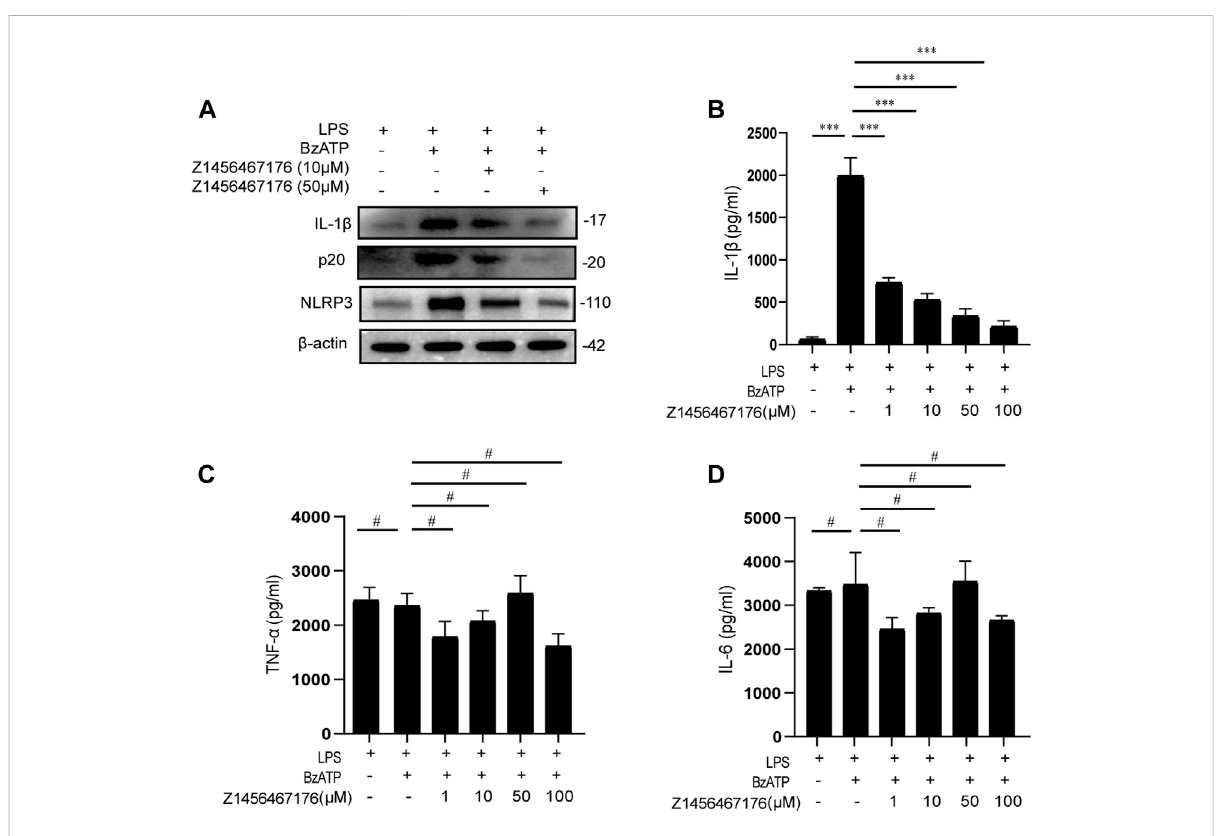
FIGURE. 3 Z1456467176 inhibits the P2X7R-NLRP3-IL-1 β pathway invitro . (A) WB ofNLRP3,caspase-1 (p20), and IL-1 β inlysates from LPS-primed PBMCs of gout patients treated with Z1456467176 (10, 50 μ M) for 30 min and stimulated with BzATP (100 μ M). (B – D) ELISA of IL-1 β , TNF- α , and IL-6 in culture supernatantsfrom LPS-primed PBMCs of goutpatients treated with Z1456467176for 30 min and stimulated with BzATP. Data are presented as the means ± S.E.M.s. Statistics were analyzed using Dunnett ’ s t test. n = 3. *** p <